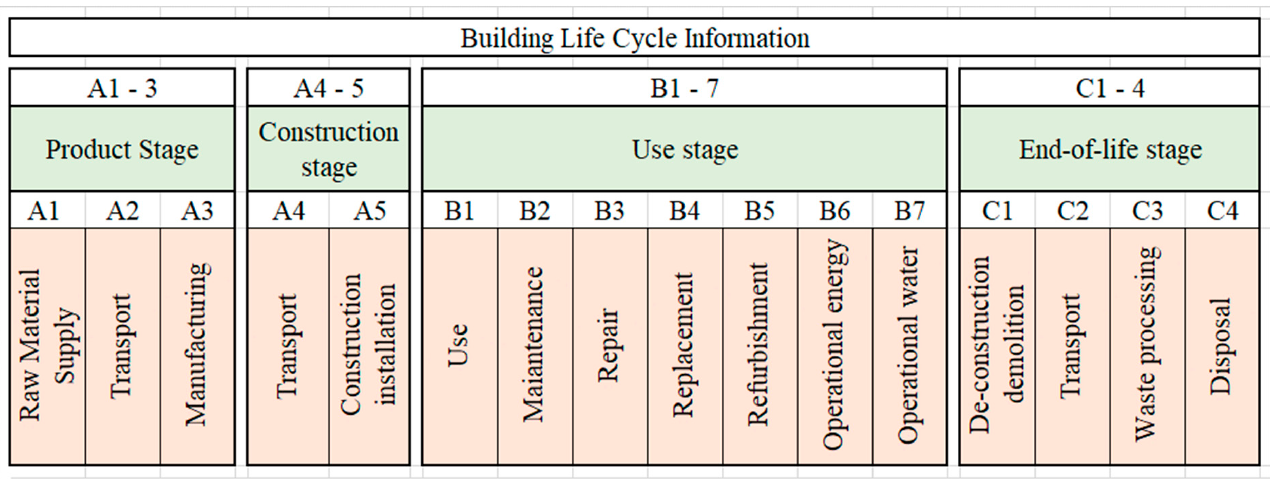
Figure 3. The 4 building life cycle stages and 16 sub-stages analysed in the case study, as designated by the European construction sustainability standard EN15978.